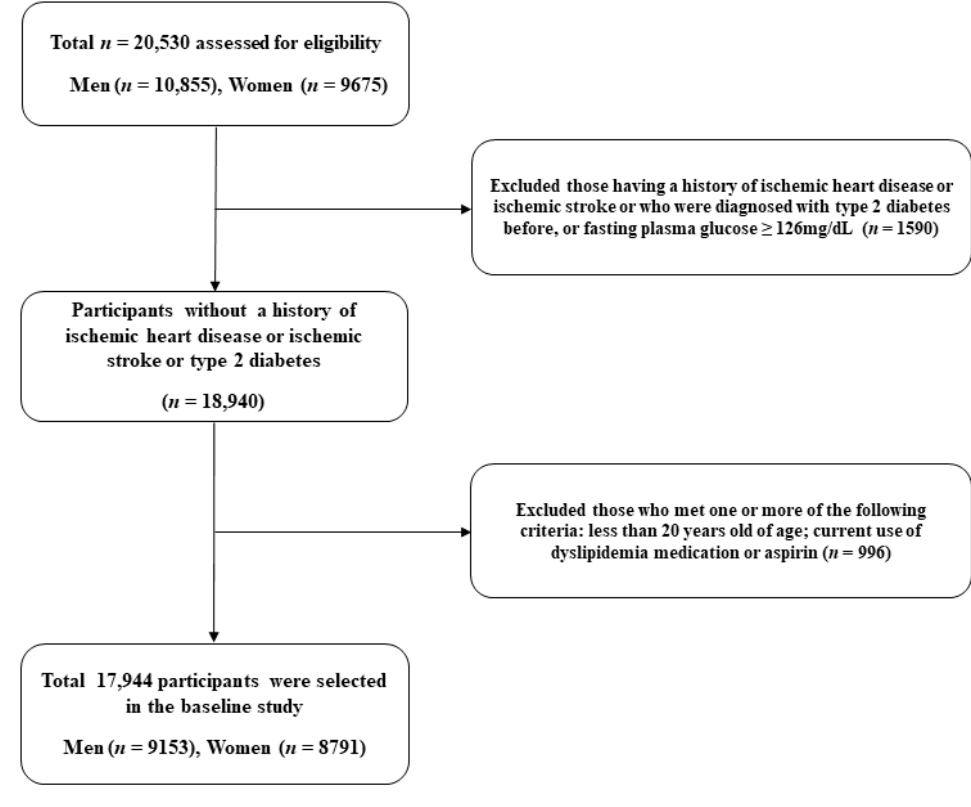
Figure 1. Study population selection.